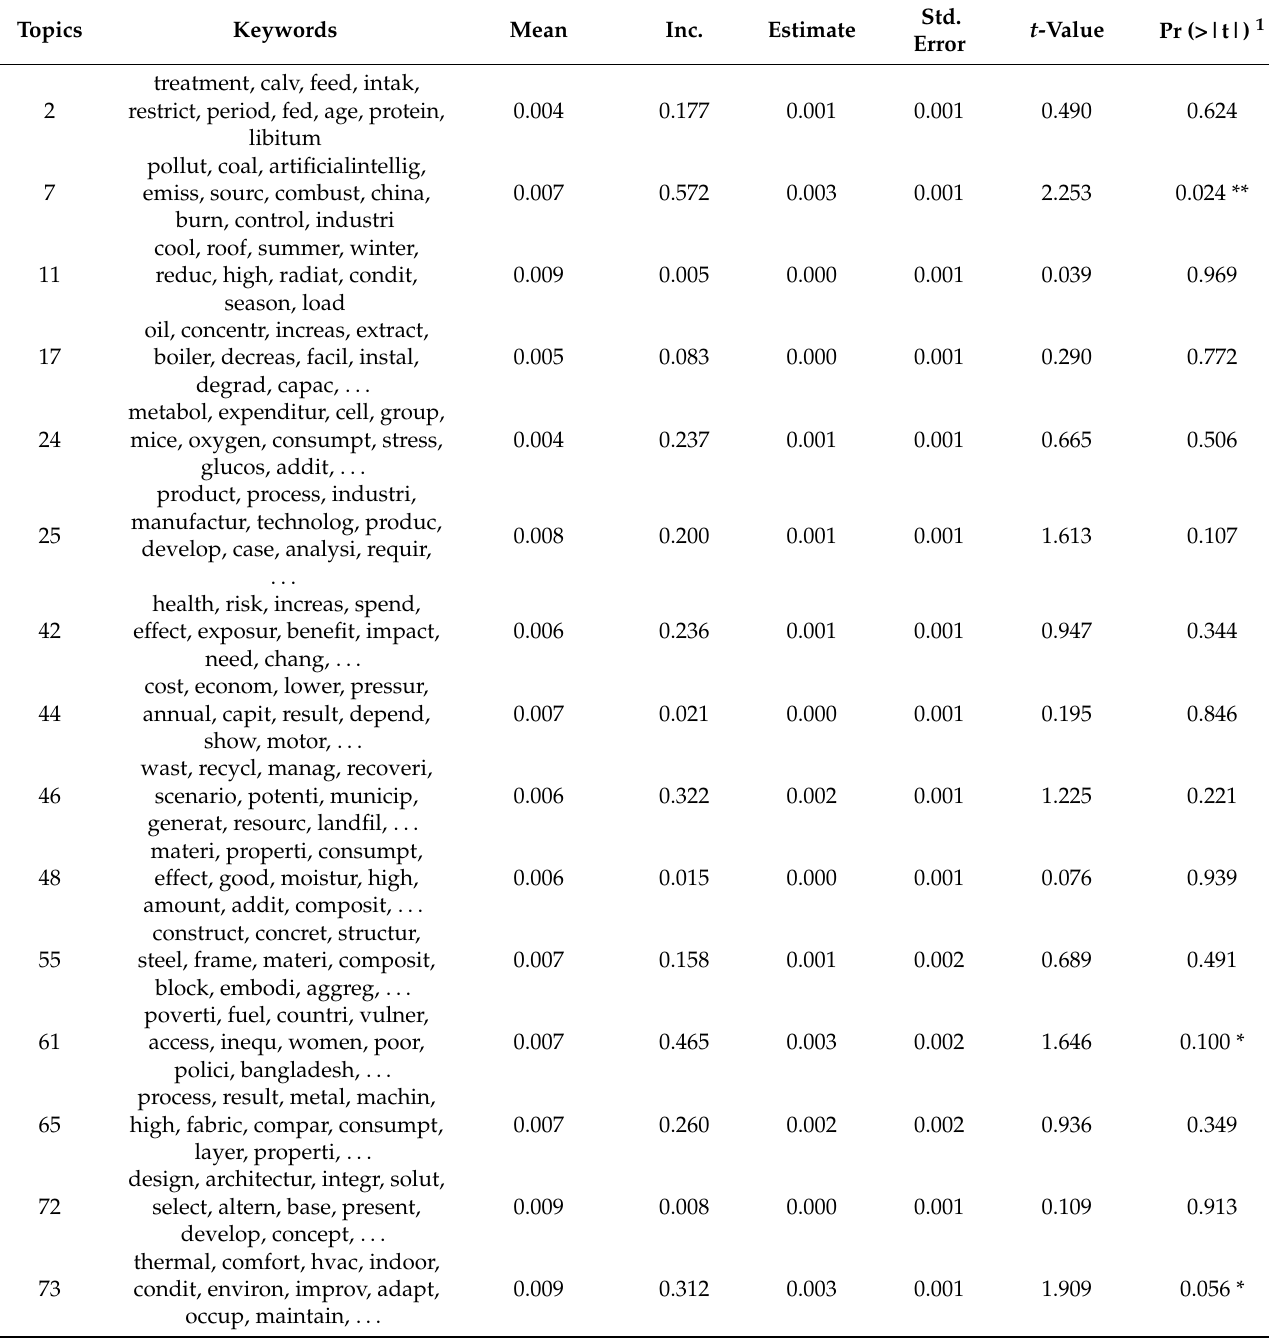
Table 3. Topics selected as Weak